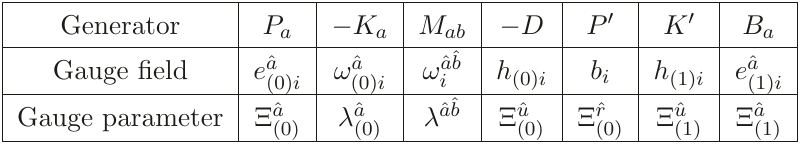
Table 1 . Generators, gauge fields and corresponding